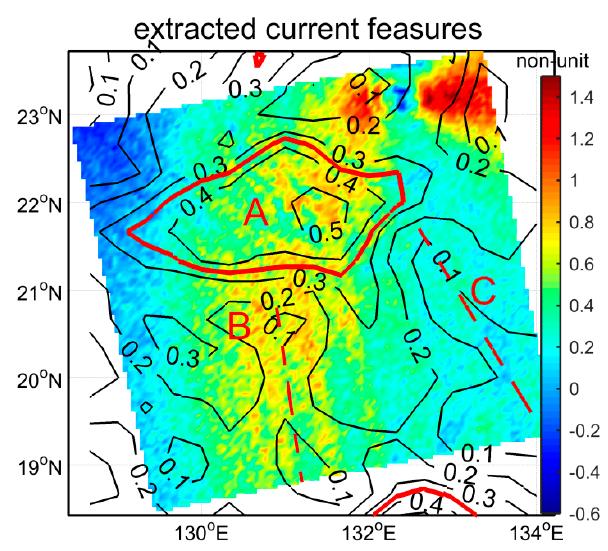
Figure 7. Ocean currents’ manifestations (colors) from dual-polarized ScanSAR images. The isoclines are the OSCAR currents.